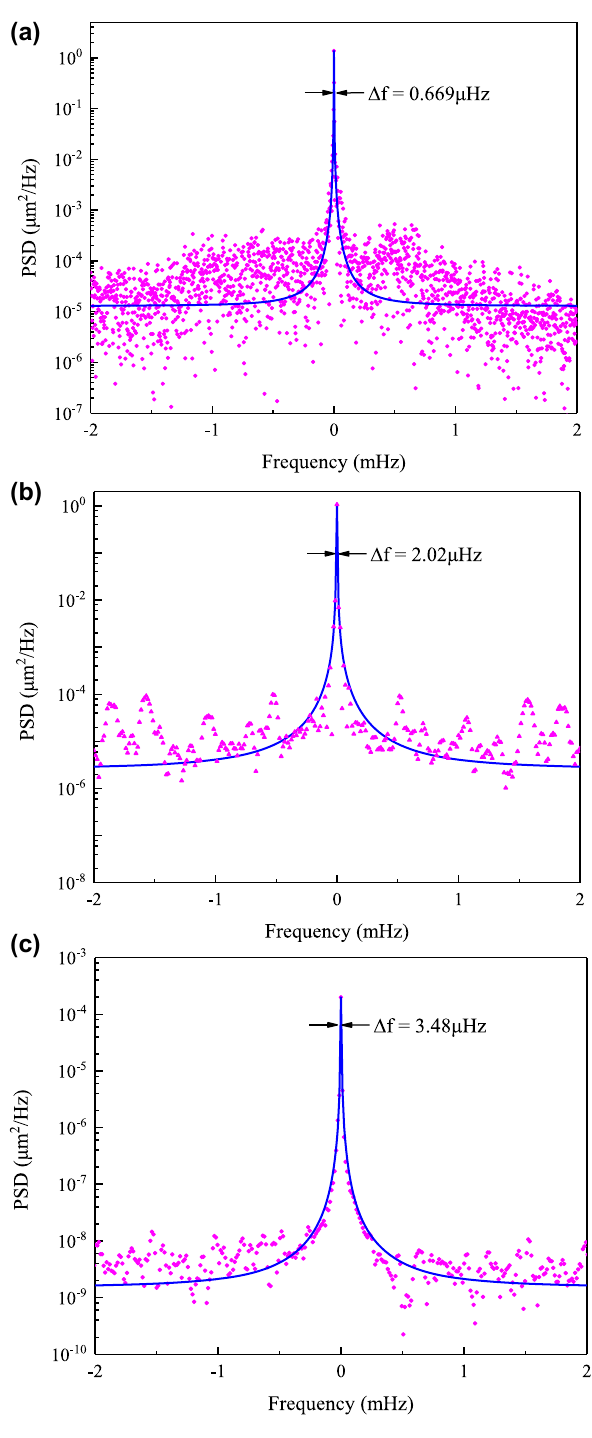
Figure 5: The PSD signals under various orbiting conditions and experimentally measured PSD signals fitted with Lorentzian function of the orbital particle at various modes. (a) 100 Hz orbiting PSD signals at low pressure (1 mbar) showing a linewidth of 0.669 μ Hz, yielding a quality factor of Q = 1.47 × 10 8 . (b) 100 Hz PSD orbiting signal at atmosphere pressure with 2.02 μ Hz and Q = 4.95 × 10 7 . (c) 500 Hz orbiting signal at low pressure (1 mbar) with 3.48 μ Hz linewidth and Q = 1.43 × 10 8